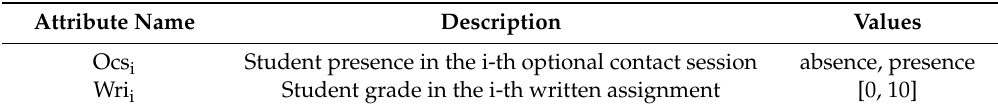
Table 2. Academic performance attributes, i ∈ { 1, 2 } .